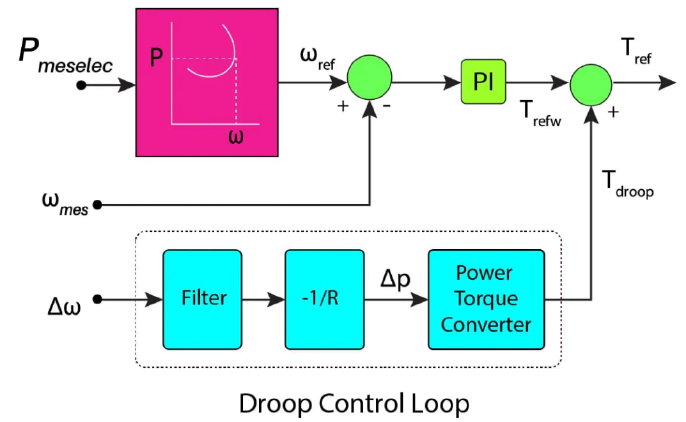
Figure 11. Droop control